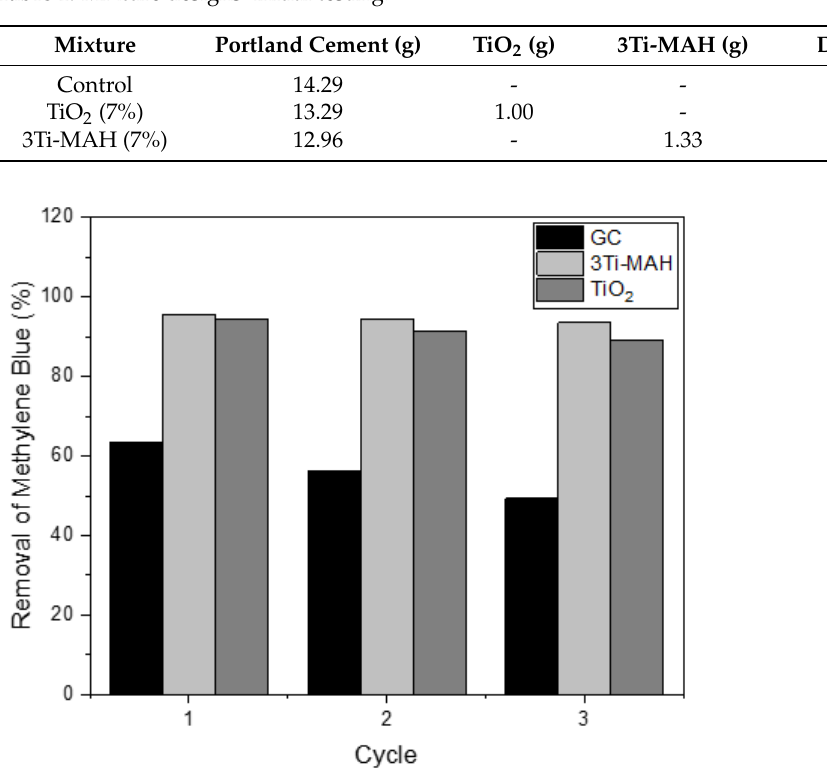
Figure 12. Results of photocatalytic testing of TiO 2 and 3Ti-MAH.